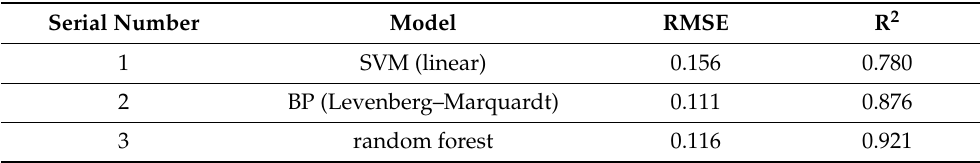
Table 10. Comparison of prediction performance of different